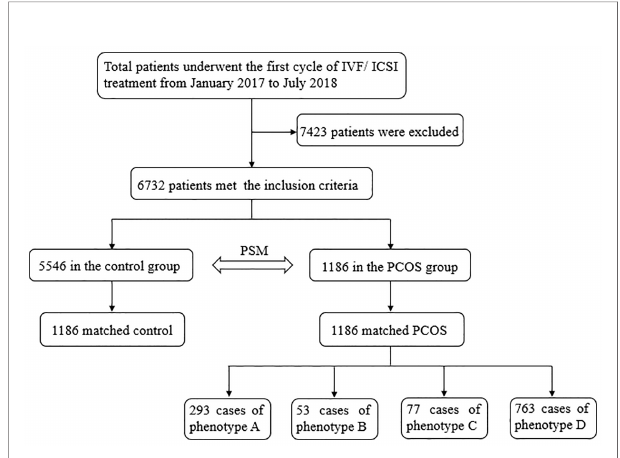
FIGURE 1 | Flow chart database searching pathway and group